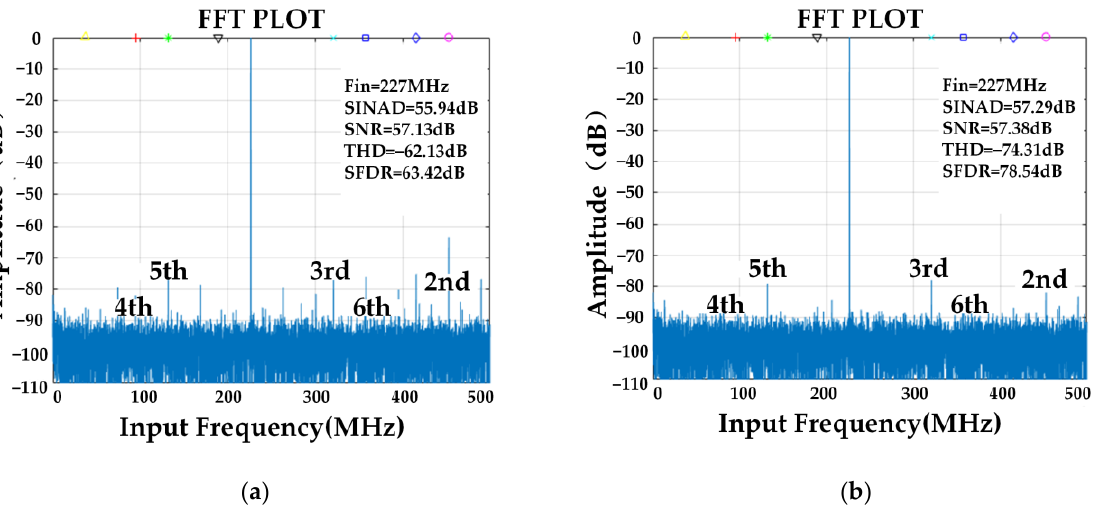
Figure 16. DNL and INL after calibration based on 65536 sample points. ( a ) DNL after calibration; ( b ) INL after calibration.